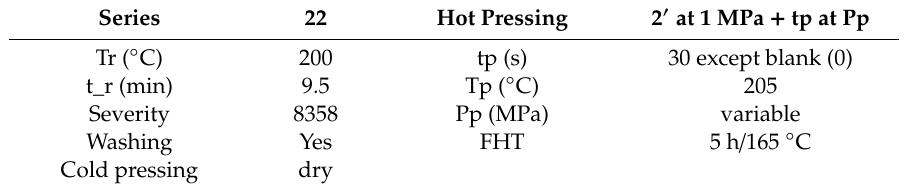
Table 3. Conditions of series 22.